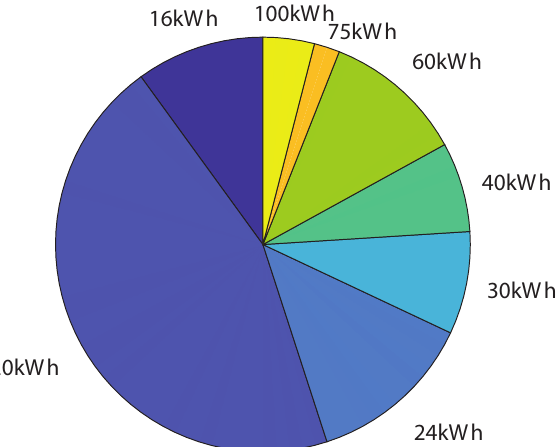
Figure 4. Discrete probability distribution for EV battery